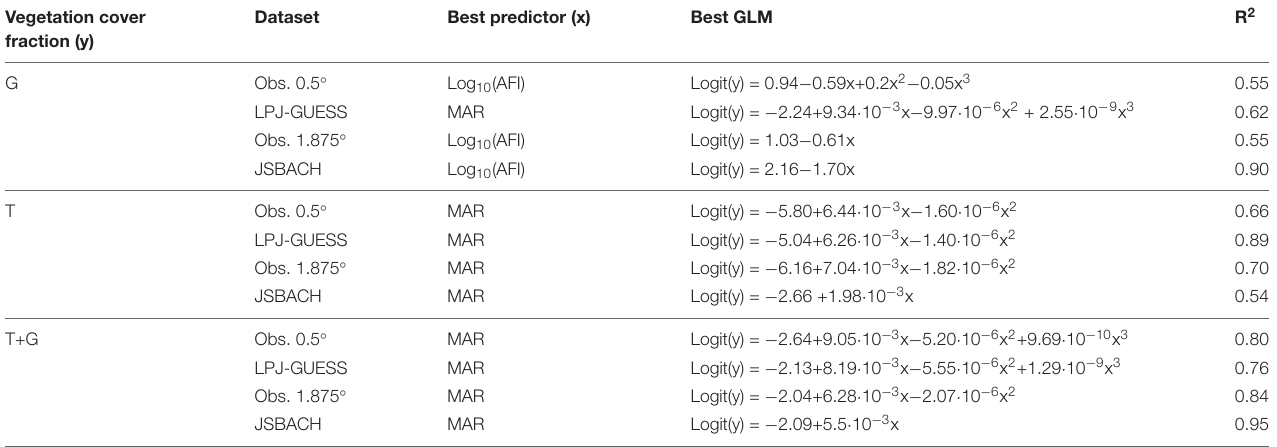
TABLE 1 | Results of GLM analyses for obs. 0.5 ◦ , LPJ-GUESS, obs. 1.875 ◦ and JSBACH datasets. Vegetation cover fraction